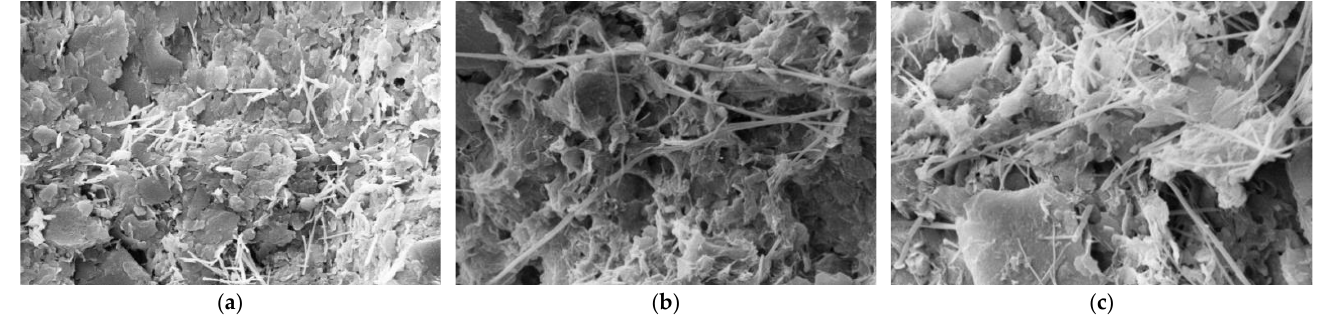
Figure 9. SEM images at different curing temperatures (at a magnification of 20K): ( a ) T = 18 °C ; ( b ) T = 36 °C ; ( c ) T = 46 °C .